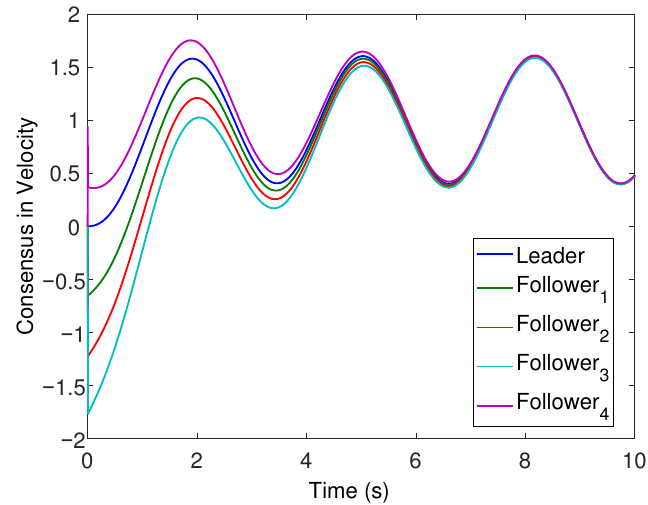
Figure 3. Velocity consensus of the four followers with leader velocity trajectory.